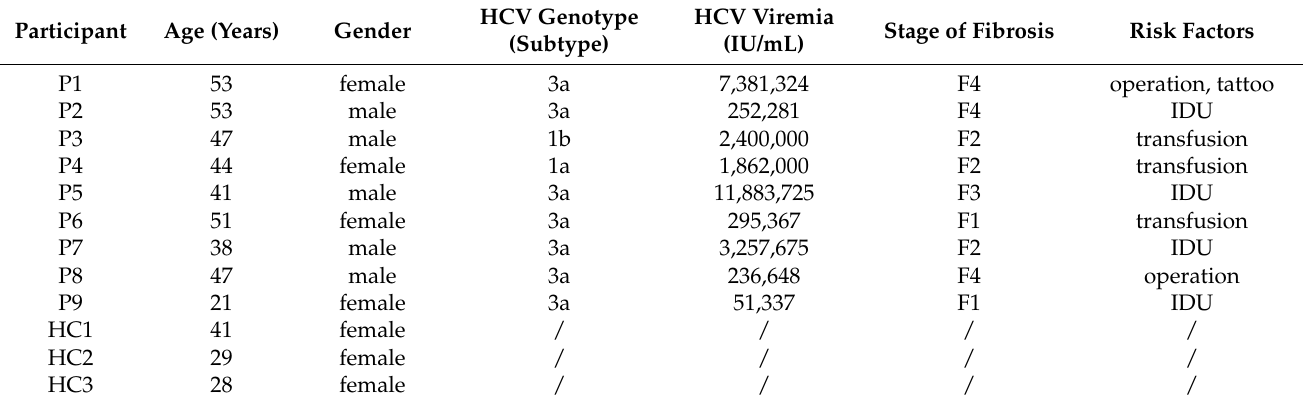
Table 1. Demographic, clinical and virology data of the study population.